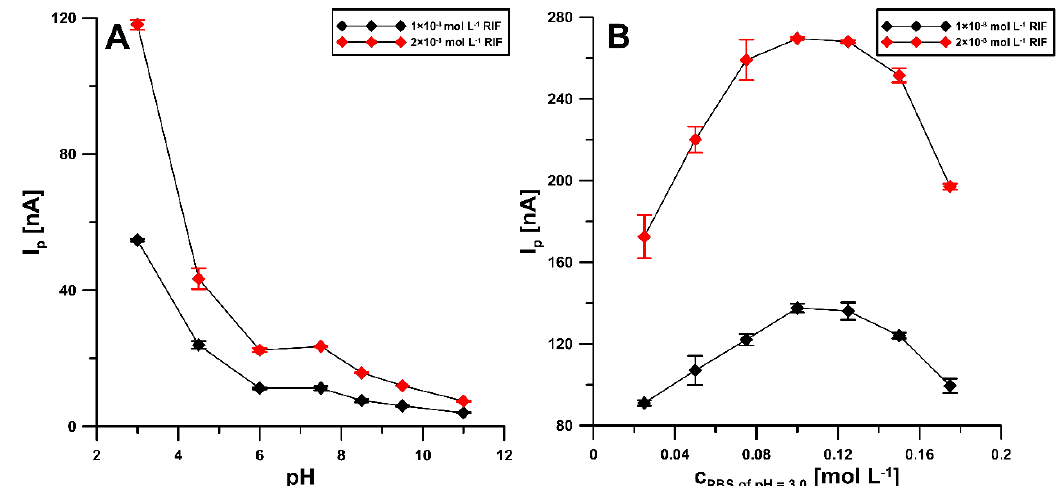
Figure 4. Influence of pH value ( A ) and concentration of the PBS solution of pH 3.0 ± 0.1 ( B ) on RIF peak current. The DPAdSV parameters: Eacc of − 0.25 V, tacc of 60 s, Δ E A of 50 mV, ν of 100 mV s − 1 and t m of 10 ms.